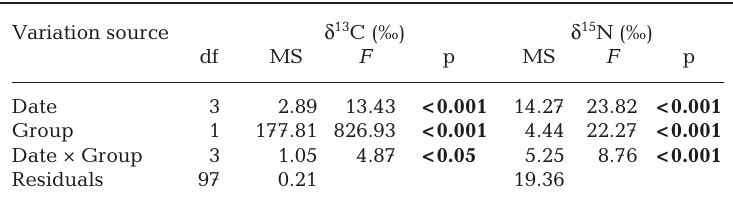
Table 4. ANOVA testing the effect of group (pearl oysters Pinctada margaritifera vs. epibionts), time (date), and their interaction, on nitrogen and carbon isotope ratios in Mangareva. Significant (p < 0.05) values are highlighted in bold